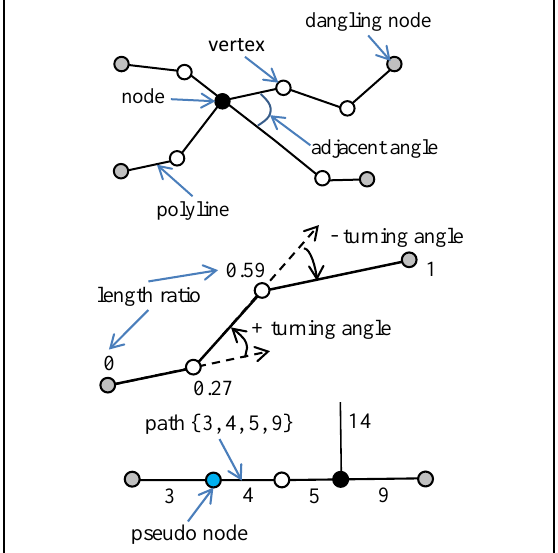
Figure 2. Path-node structures in pattern graphs (Yang et al.